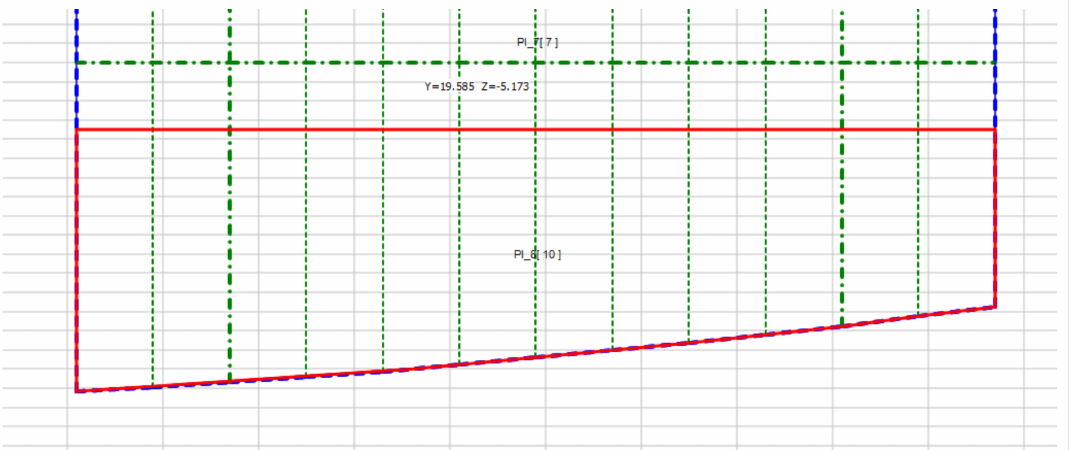
Figure 20. An example of the correct formation of the plate loop in the case of the conjunction of a clipping polygon side (deck grillage outlines) and a clipped polygon side (deck plating loop). In this Figure green thick dashed line—primary supporting members, thin dashed line—stiffeners, blue dotted line—deck grillage borders. The red thick line shows the correct plate